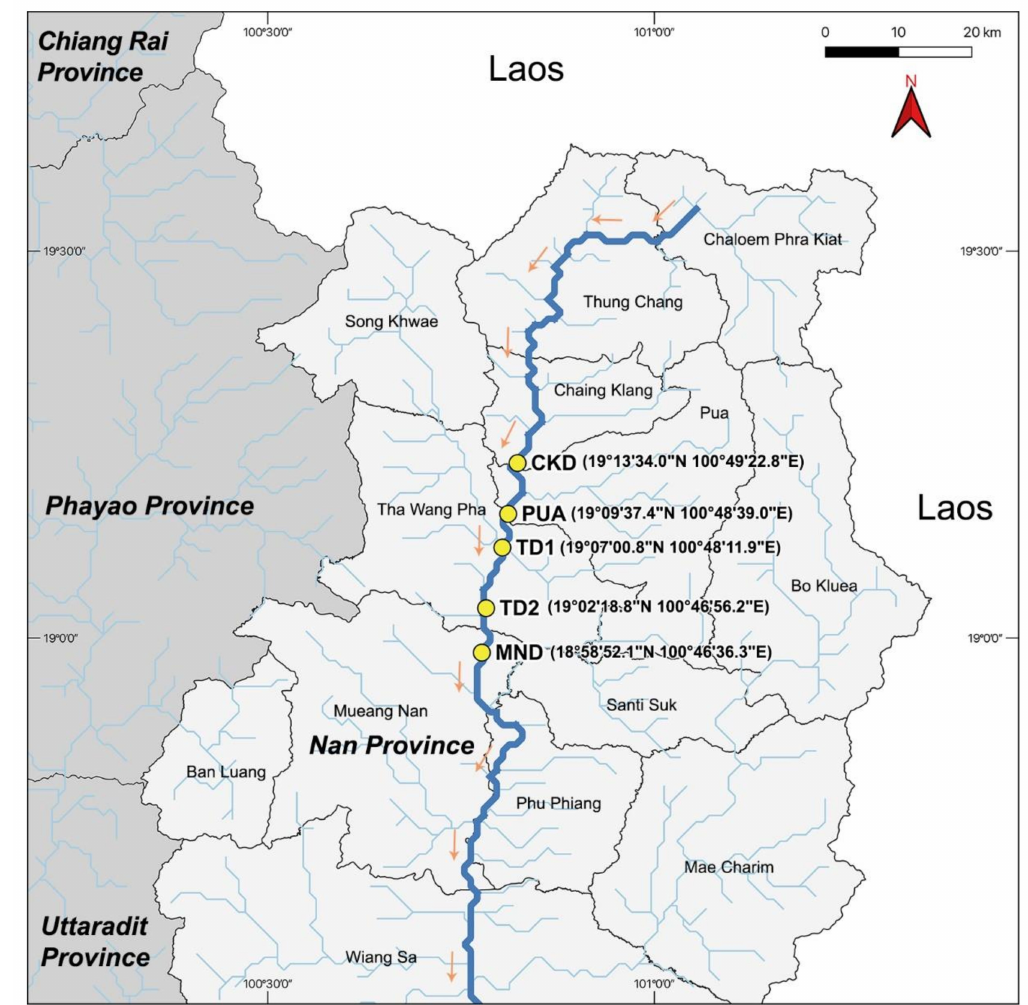
Figure 1. Five sample collecting sites in Nan River, Nan Province, located in four different districts. CKD located in Chiang Klang district, PUA located in Pua district, TD1 and TD2 located in Tha Wang Pha district, and MND located in Mueang Nan district. Only three locations (CKD, PUA, and TD1) were Cladophora dominant. Yellow dot represents each collecting site. Bold blue line represents the Nan River. Orange arrows represent the flow direction. Other blue lines represent other smaller rivers and